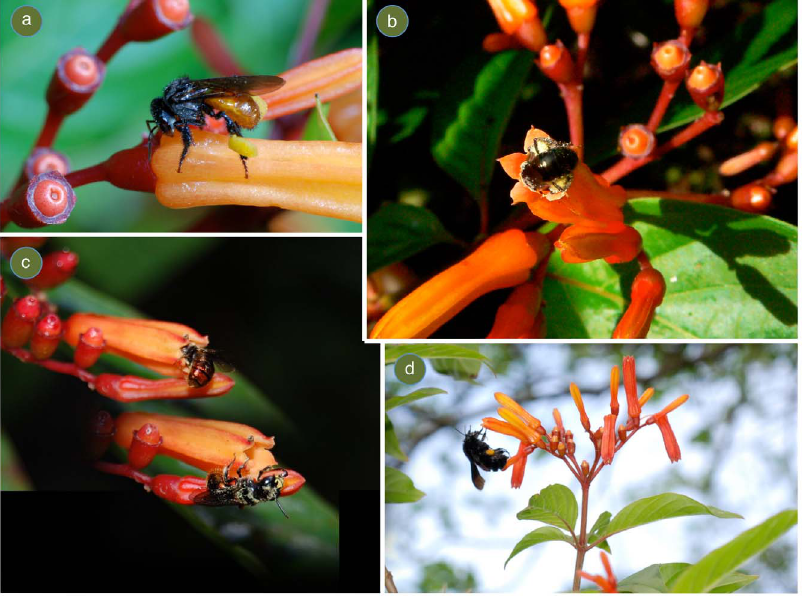
Figure 2. Bees pollinating Hameliapatens . (a) Trigona fulviventris with collected H. patens pollen (b) Halictidae species emerging from H. patens corolla, covered in pollen (c) Ceratina species, emerging from corolla and covered in pollen (d) Bombus pullatus with collected H. patens pollen.